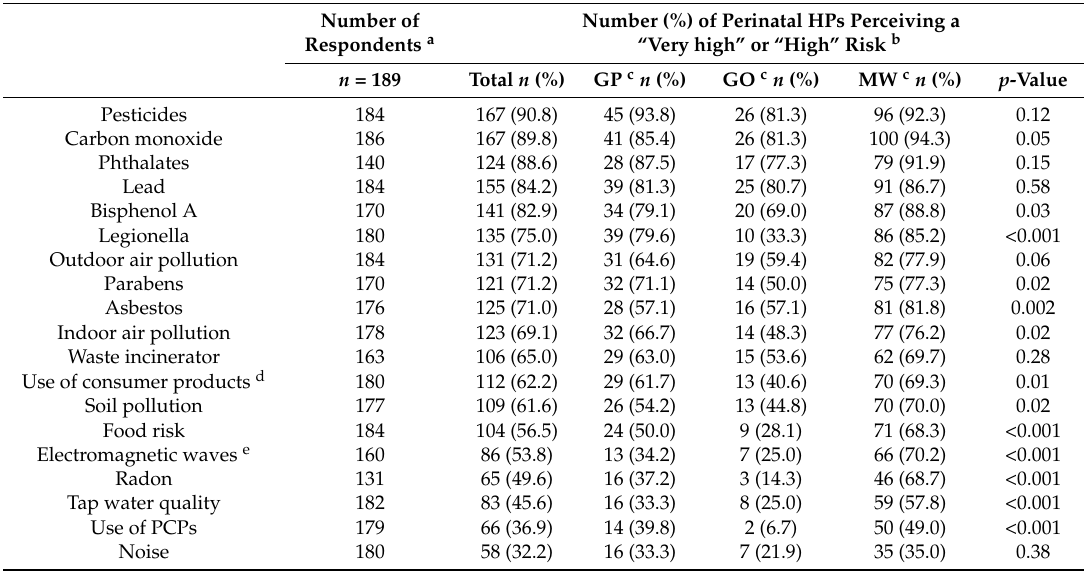
Table 2. Perception of risk levels (“very high” or “high”) for the health of pregnant women and their unborn baby by perinatal health professionals